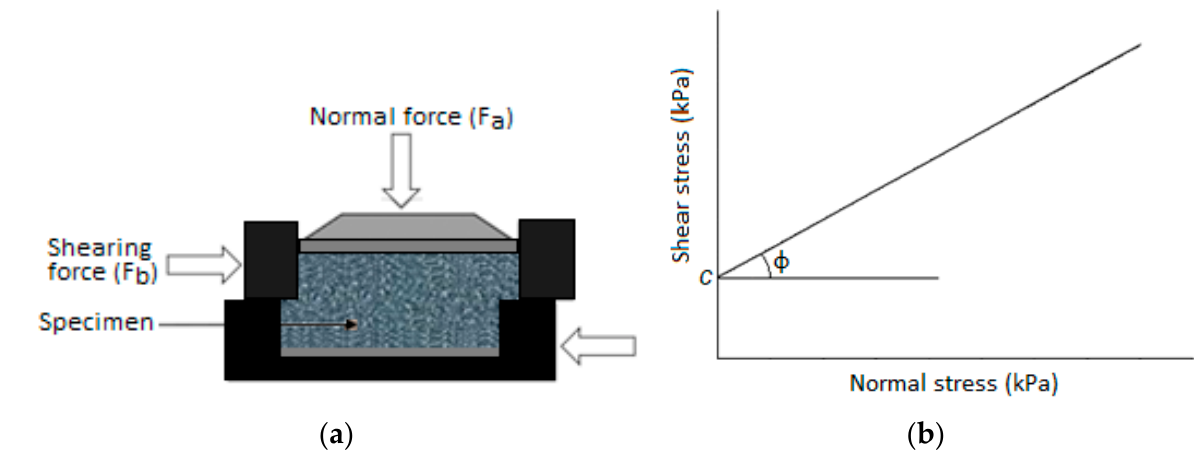
Figure 11. ( a ) Direct shear box schematic, and ( b ) normal and shear stress expected relationship. In the modified shear box test, the bottom half of the shear box is replaced with